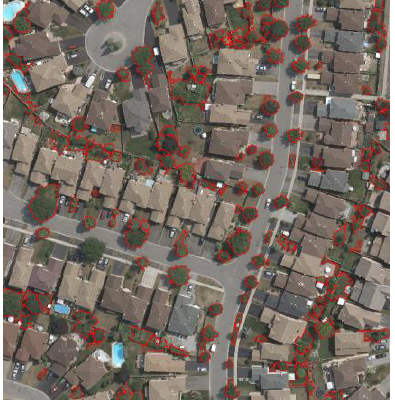
Figure 4. Individual tree crowns delineated from the VHR imagery in Site 2.